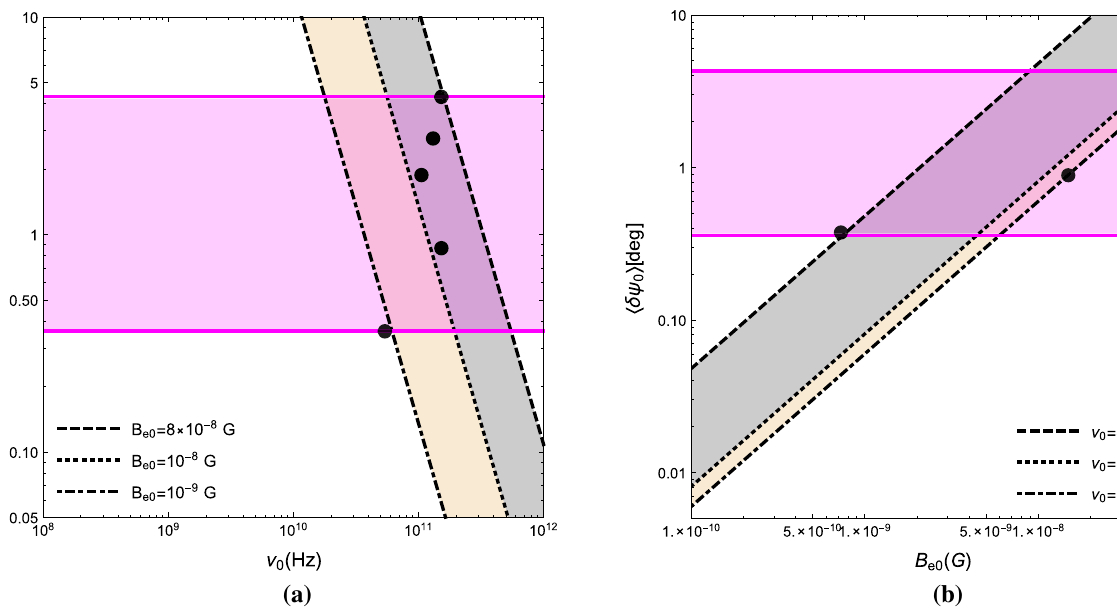
Fig. 9 In a logarithmic scale plots of the root mean square of the rota- tion angle of the CMB polarization (cid:19) δψ 0 (cid:20) (in degrees) given in (77) as a function of the CMB frequency ν 0 ∈ [ 10 8 , 10 12 ] (Hz) for some specific values of the magnetic field amplitude B e 0 are shown. In b logarithmic scale plots of the root mean square of the rotation angle of the CMB polarization plane δψ 0 (in degrees) given in (77) as a function of the magnetic field amplitude B e 0 ∈ [ 10 − 10 , 8 × 10 − 8 ] (G) for some spe- cific values of the frequency ν 0 are shown. In both a and b the region in magenta colour between 0 . 36 ◦ ≤ (cid:19) δψ 0 (cid:20) ≤ 4 . 3 ◦ represents the region where experimentally do exist constraints on (cid:19) δψ 0 (cid:20) . In a the first black point from the top is the constraint found by BOOM3 experiment [36] at the frequency ν 0 = 145 GHz where | δψ 0 | = 4 . 3 ◦ . The second point